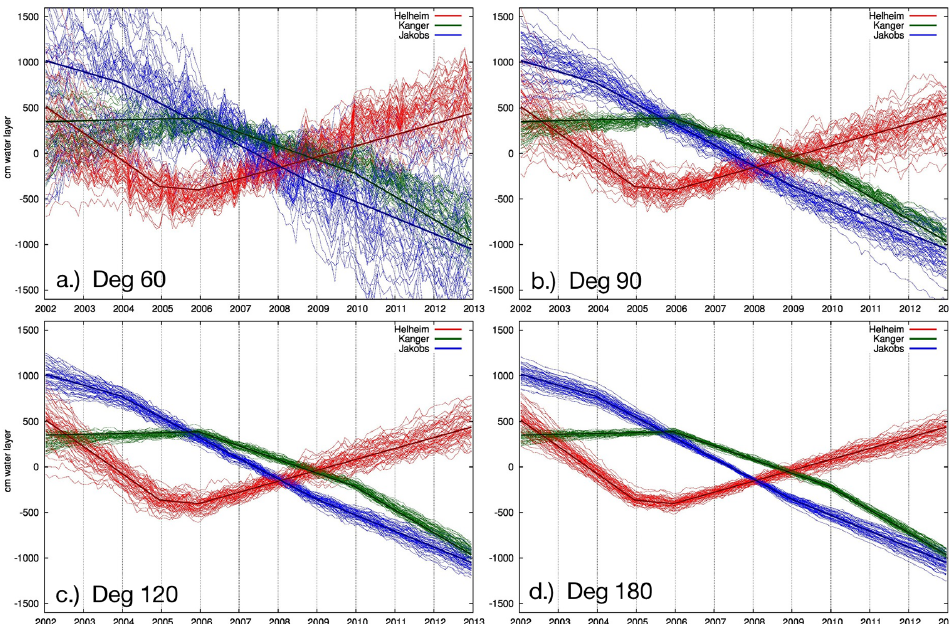
Figure 8. Visualization of the spread caused by the combined SMB and glacial basin misfit errors, at the three glaciers, for maximum degrees